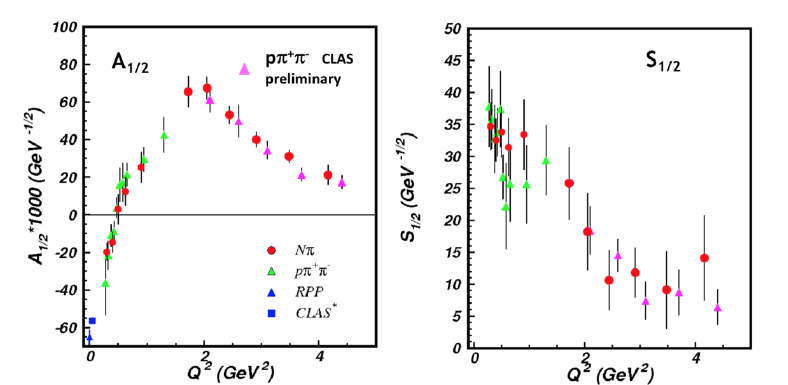
Fig. 5. (Color online) Electromagnetic transition form factors A 1/2 and S 1/2 of the Roper resonance.